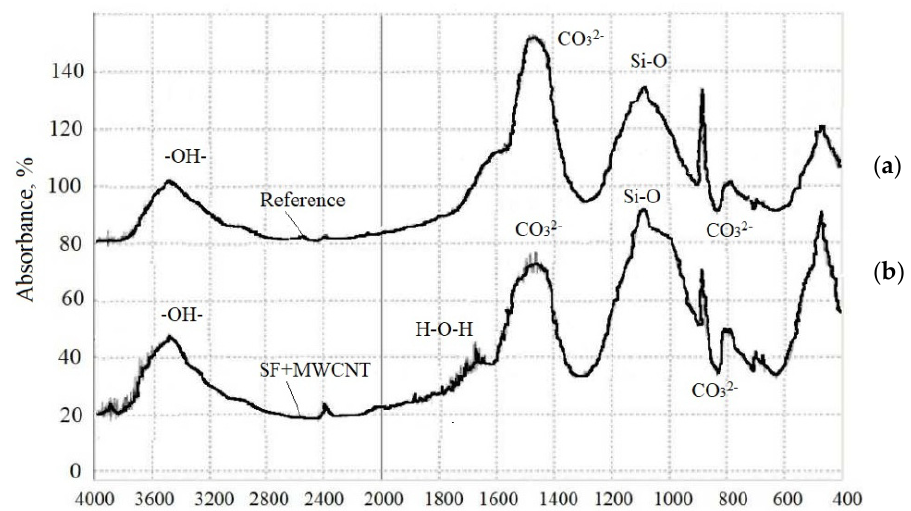
Figure 14. Infrared spectroscopy for the hardened cement paste modified with silica fume and nanotubes and cured for 28 days under normal conditions: ( a ) reference sample; ( b ) modified sample.